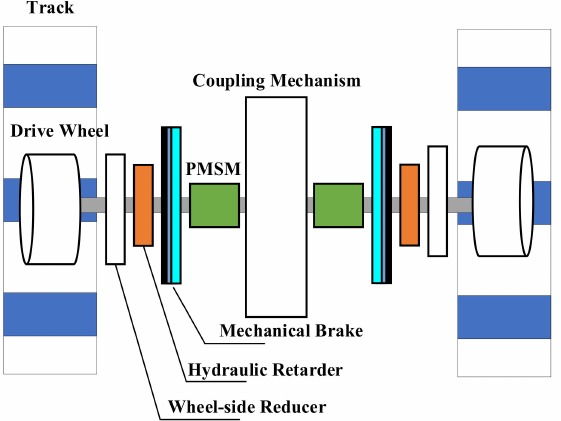
Figure 4. Schematic diagram of the brake system of a high-speed dual-motor electric drive tracked vehicle.